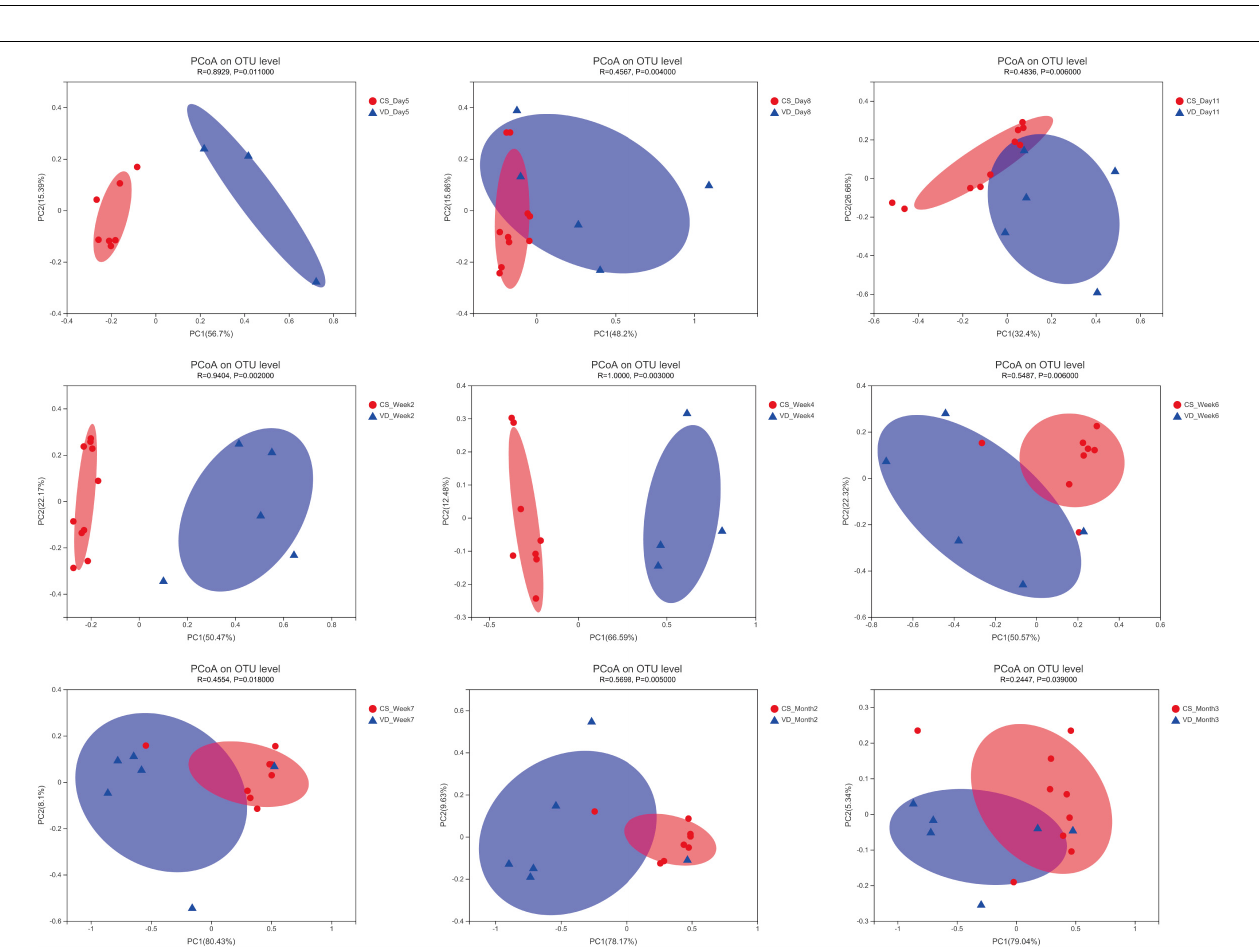
FIGURE 5 | Principal coordinates analysis of the infant’s gut microbiota among different time points based on delivery mode. R and p were calculated using ANOSIM.